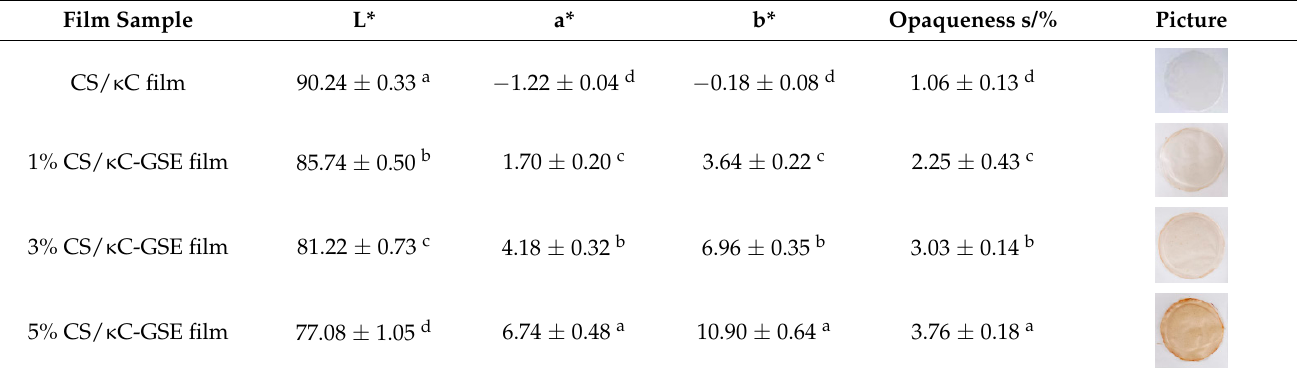
Table 2. Color, optical properties, and opacity of CS/ κ C-GSE films with different concentrations of GSE.